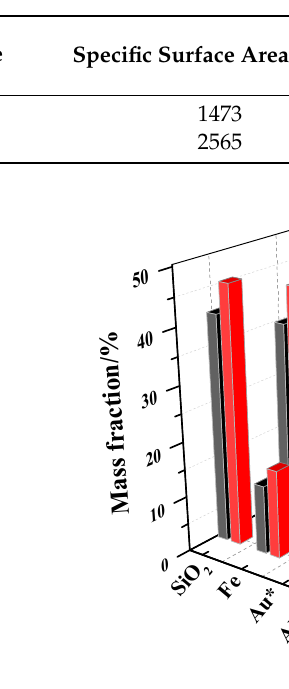
Figure 2. Main chemical compositions of the different size fractions.